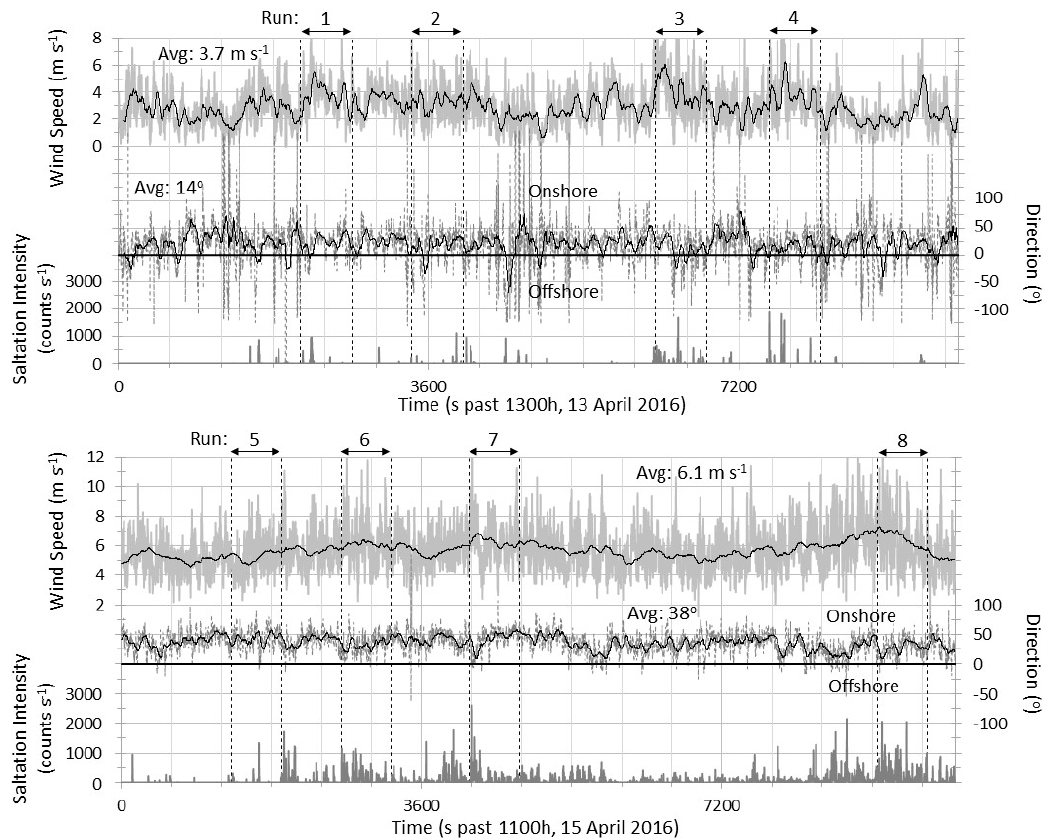
Figure 9. Time series of incident wind speed (upper solid grey line with black 60 s running mean, upper left axis, m s − 1 ), direction (middle dashed grey line with black 60 s running mean, right axis, degrees), and saltation intensity (bottom grey bars, bottom left axis, counts s − 1 ) on 13 April (top graph) and 15 April (bottom graph). Wind speed and direction are from T2B 1.5m and Saltation Intensity is from W1 (Figure 7). Runs are indicated on the top of each graph. The Wenglor (model YH08PCT8) laser particle counter (80 mm path length, 0.6 mm beam width, laser sampling beam was placed 0.031 m above the surface, located 5 m seaward from the LWD on T1, and aligned toward the incoming transport direction of 150°) was used to measure saltation intensity (counts − 1 ).